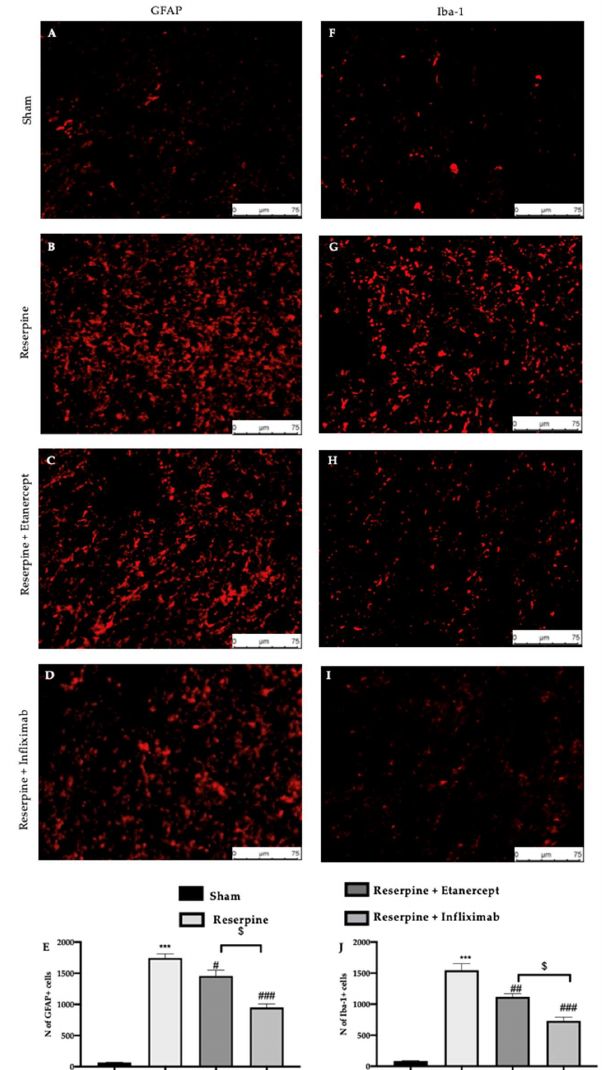
Figure 5. Efficacy of etanercept and infliximab administration on microglia and astrocytes reserpine induced. Immunofluorescence analysis of GFAP: ( A ) Sham, ( B ) Reserpine, ( C ) Reserpine+Etanercept, ( D ) Reserpine+Infliximab, ( E ) Number of GFAP positive cells. Immunofluorescence analysis of Iba-1: ( F ) Sham, ( G ) Reserpine, ( H ) Reserpine+Etanercept, ( I ) Reserpine+Infliximab, ( J ) Number of Iba-1 positive cells. Scale bar: 75μm. Magnification 40X. For these analyses n = 5 animals for each group were employed. Results were analysed by one-way ANOVA followed by a Bonferroni post-hoc test for multiple comparisons. A p -value <0.05 was considered significant. # p < 0.05 vs. vehicle, ## p < 0.01 vs. vehicle, *** p < 0.001 vs. sham, ### p < 0.001 vs. vehicle, $ p < 0.05 infliximab vs. etanercept.